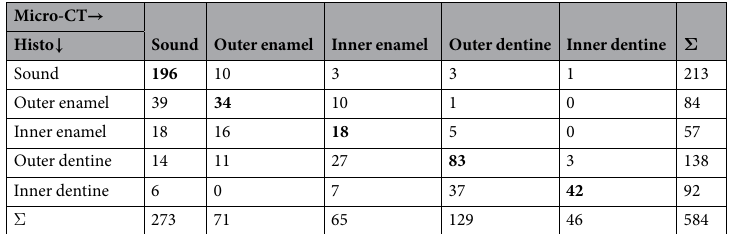
Table 2. Crosstabulation of number of surfaces scored by observing histological (columns) or micro-CT (rows) slices, per category. Corresponding categories are given in bold figures. Cross tabulation of number of surfaces scored by observing histological or micro-CT slices, per category. Corresponding categories are given in bold figures.